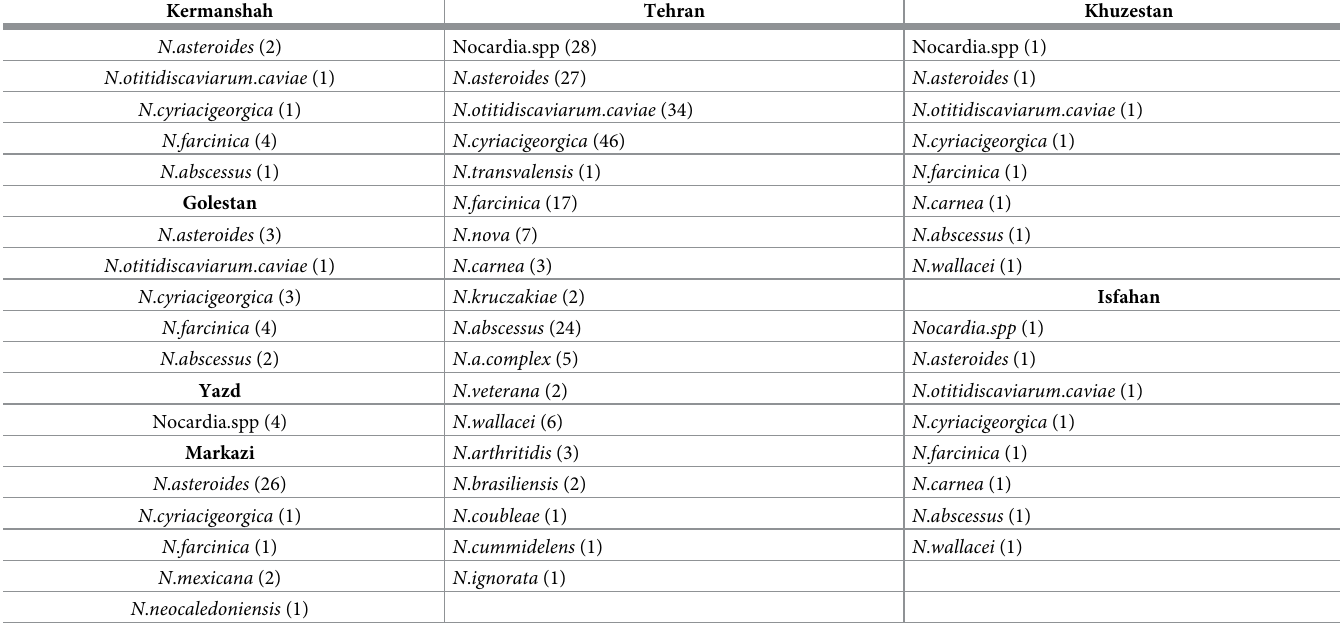
Table 3. The prevalence of Nocardia species in certain provinces of Iran (n = 338).